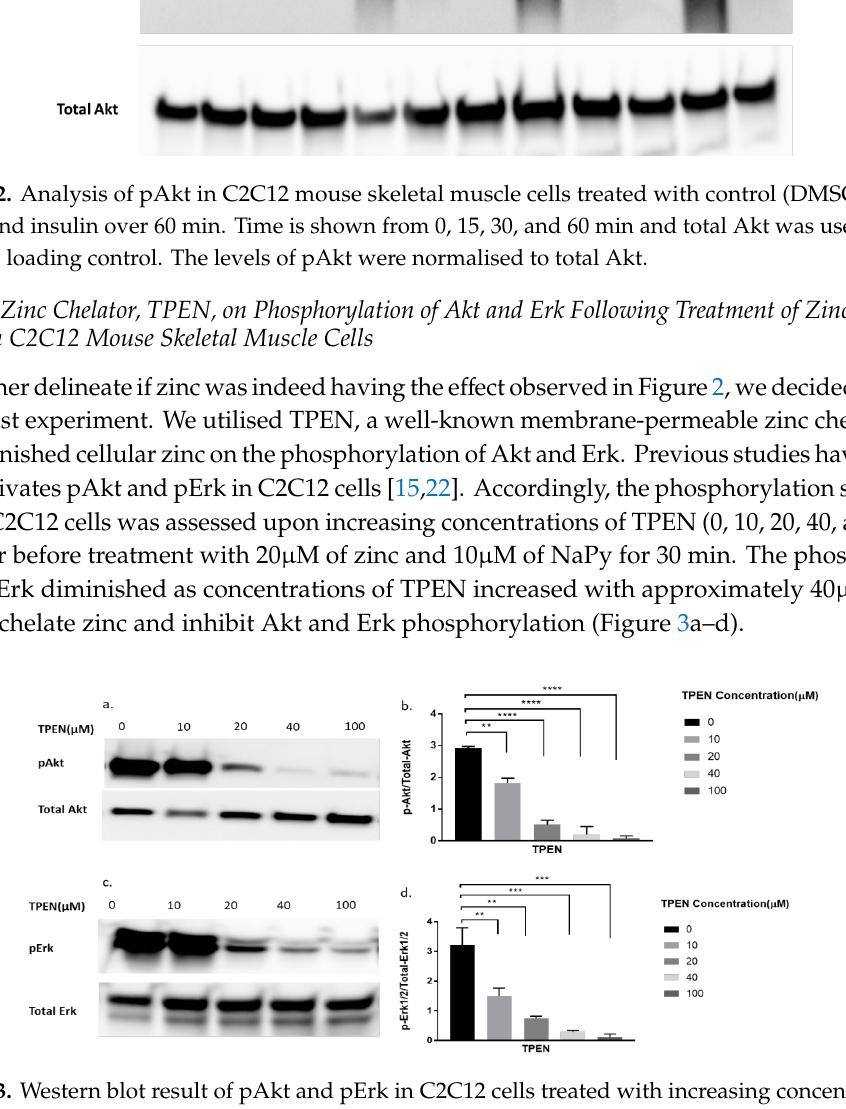
Figure 3. Western blot result of pAkt and pErk in C2C12 cells treated with increasing concentrations of TPEN. ( a , c ). Cells were treated with increasing concentrations of TPEN (0, 10, 20, 40, 100 µM) for 60 min followed by 30 min of 20 µM zinc and 10 µM NaPy treatment before harvesting total protein. Phosphorylated Akt and Erk were immunoprobed by Western blotting. Total Akt and total Erk were used as internal controls. Three independent Western blots on three independent treatments were performed. ( b , d ). Densitometry graphs for pAkt and pErk, respectively, from three independent data Western blots ** = p < 0.01, *** = p < 0.001, **** = p < 0.0001.